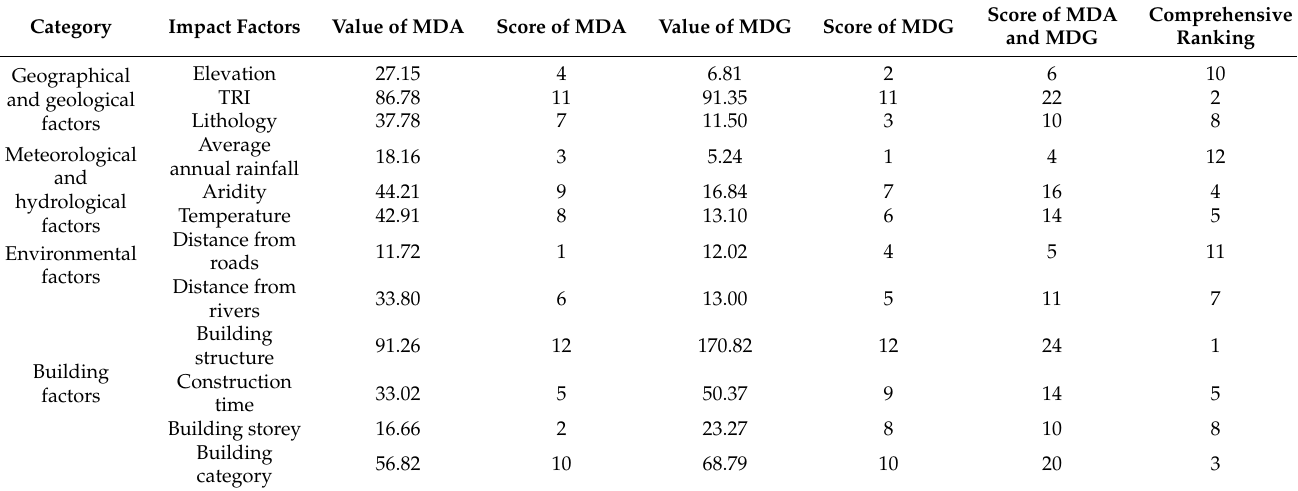
Table 6. Ranking the importance of impact